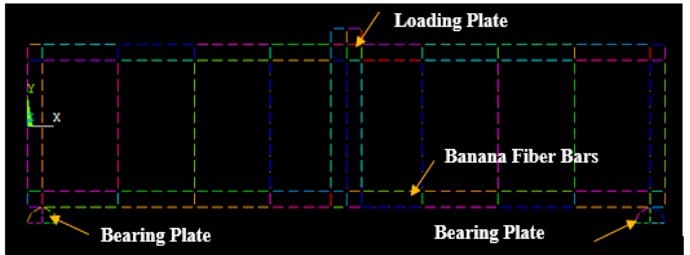
Figure 14. Reinforcement modeling for beams (B4, B6, and B7).